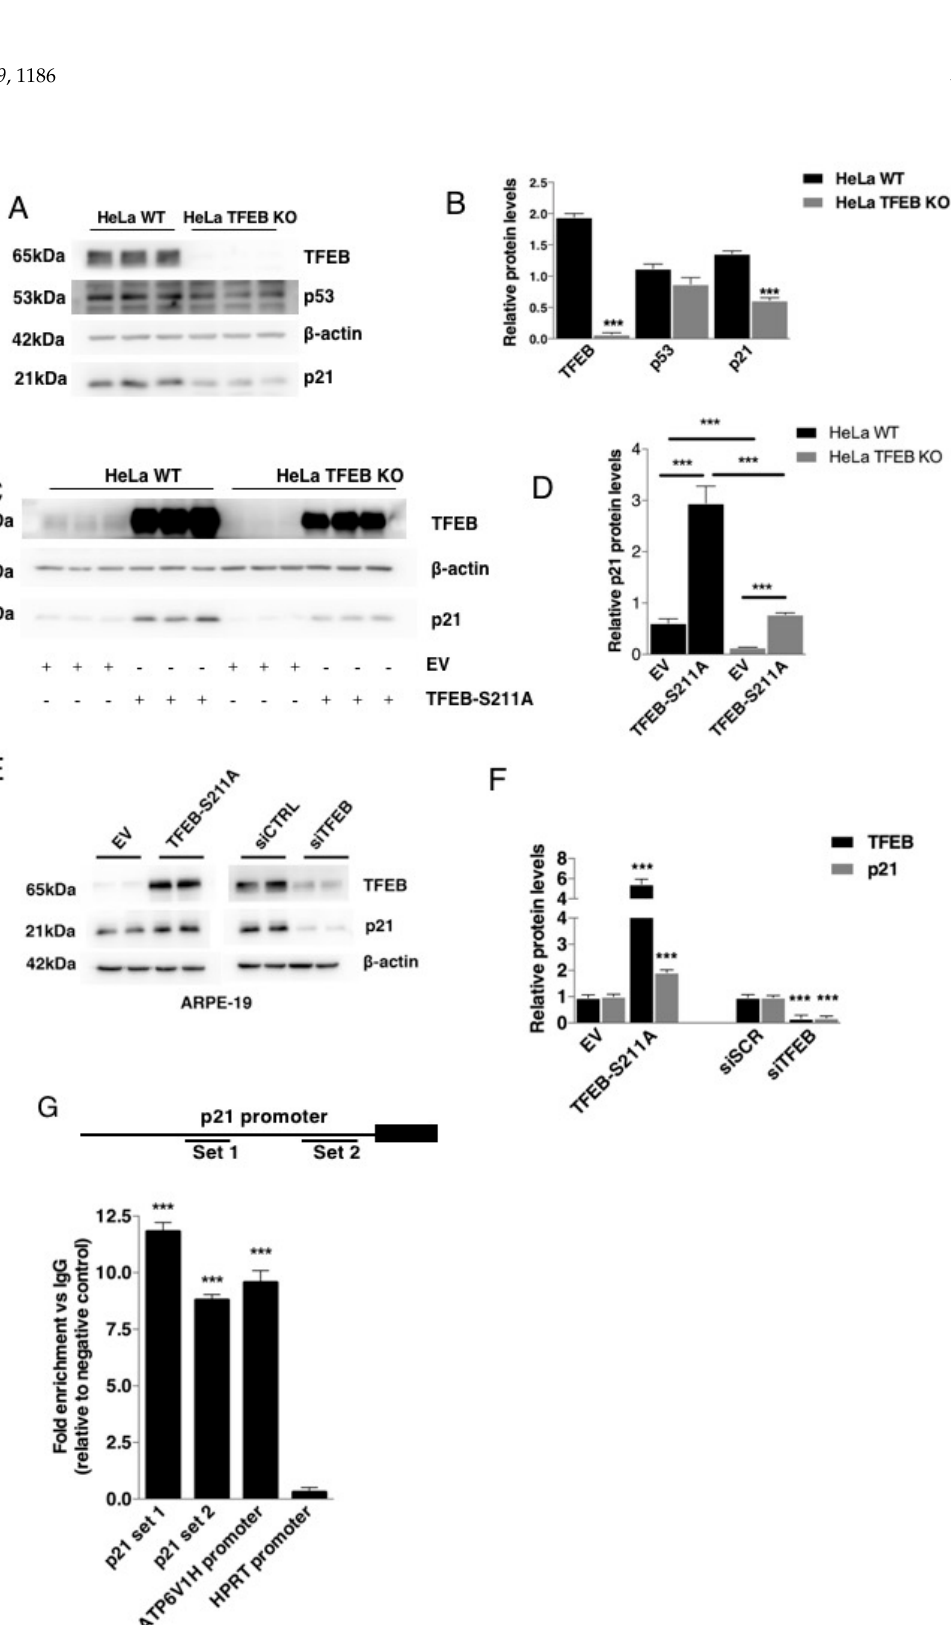
Figure 1. p21 expression is regulated by TFEB. ( A , B ) Western blot analysis and quantification of p21, TFEB, and p53 protein levels in HeLa WT cells compared with HeLa TFEB KO cells. β -actin protein levels were used as a loading control. ( C , D ) Western blot analysis and quantification of p21 protein levels in HeLa WT compared with TFEB KO cells after the transfection with either an empty vector (3xflagCMV14) or a plasmid encoding constitutive nuclear-localized TFEB (TFEB S211Ax3flag). β -